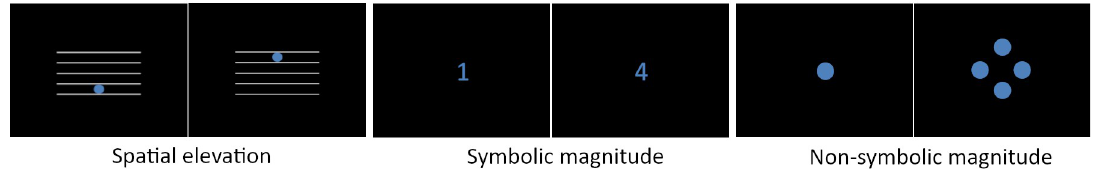
Fig 1. Examples of each of the three stimulus categories. Such pairs were used to form the experimental stimuli; both images in all three of the stimulus categories were paired (within-category) with different tones and shown consecutively within one audiovisual video (see section 2.3. for detailed description). One video therefore consisted of the first image shown for the duration of the first sound (400 ms), a 60 ms break, and of the second image shown for the duration of the second sound (400 ms), forming a one audiovisual video of the length of 860